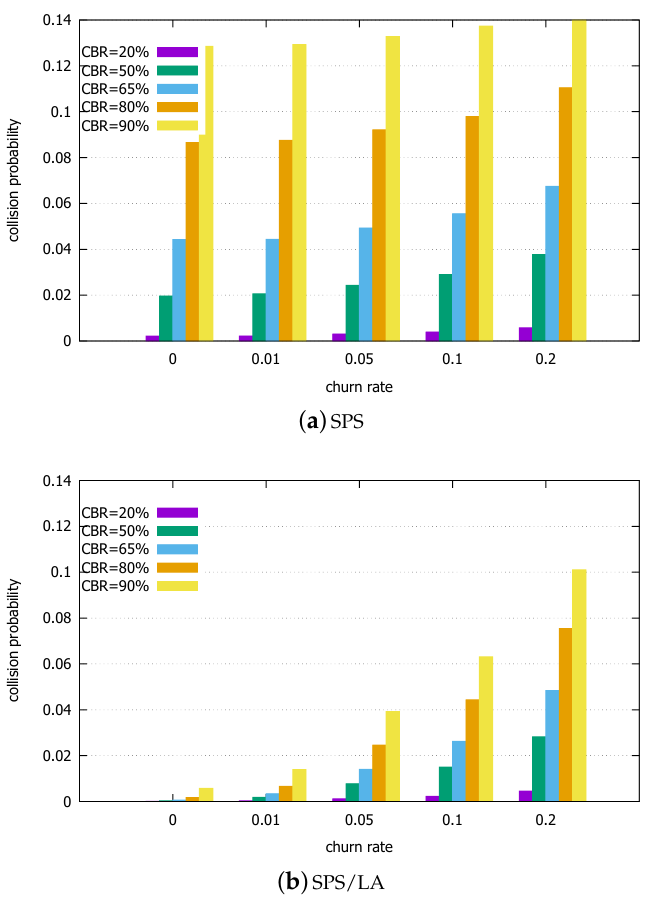
Figure 11. Collision probabilities under population churn. ( a ) SPS. ( b )